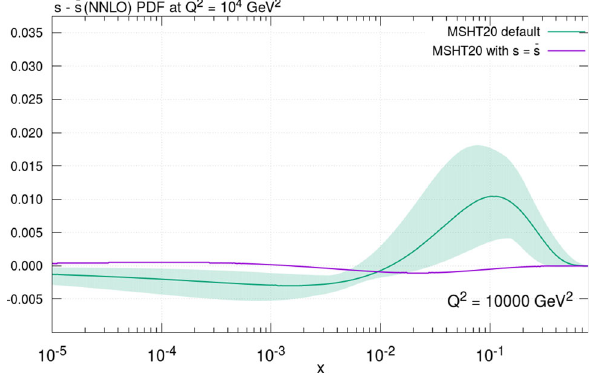
Fig. 70 s − ¯ s PDF at NNLO at Q 2 = 10 4 GeV 2 , comparing the MSHT20 global fit with the same fit when s = ¯ s is enforced at the input scale. Note a small asymmetry still results from the NNLO DGLAP